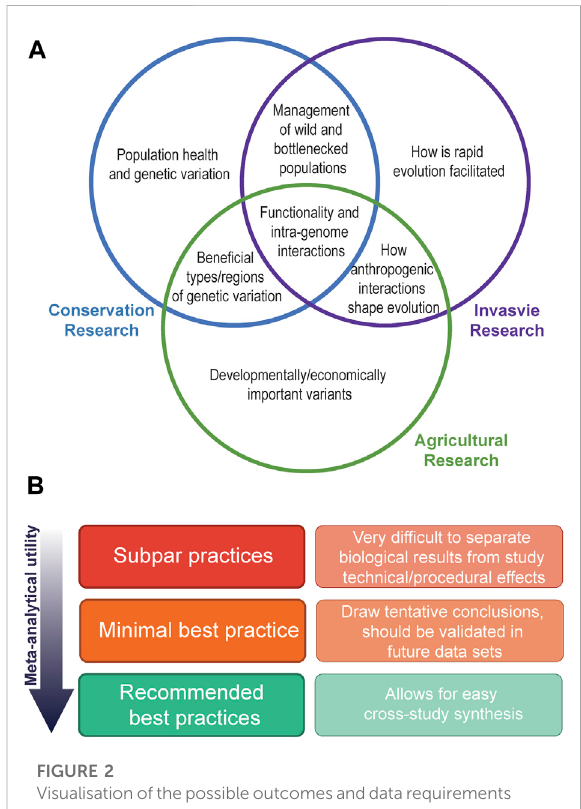
FIGURE 2 Visualisationofthepossibleoutcomesanddatarequirements of cross study synthesis in evolutionary and population genetics. Panel (A) depicts common research outcomes from studies of invasive, conservation, and agricultural population and evolutionary genomics research, and their overlap. Panel (B) depicts the need for highly curated and reproducible datasets to enable con fi dent cross-study comparisons. Best practices will often be speci fi c to the variant types being called and the research setting they are being conducted in (e.g., Olson et al., 2015; Cameron et al., 2019; Koboldt 2020), and will often be limited by fundingandresourceavailability.Ingeneral,minimalbestpractices should be informed by both the technical limitations of the sequence technology used (e.g., quality checks of the right type and stringency), as well as biologically informed decision making (e.g., accounting for population structuring when conducting downstream analysis such as outlier